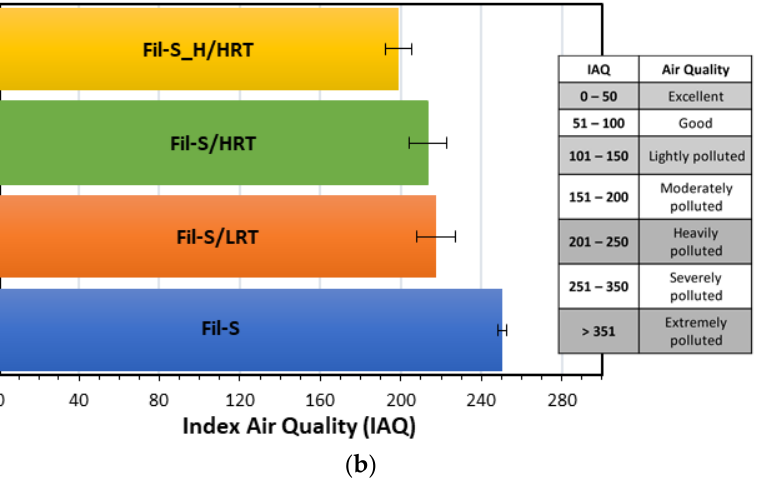
Figure 6. Index for Air Quality (IAQ) values for: ( a ) PW and ( b ) Fil-S samples subjected to different degassing conditions.